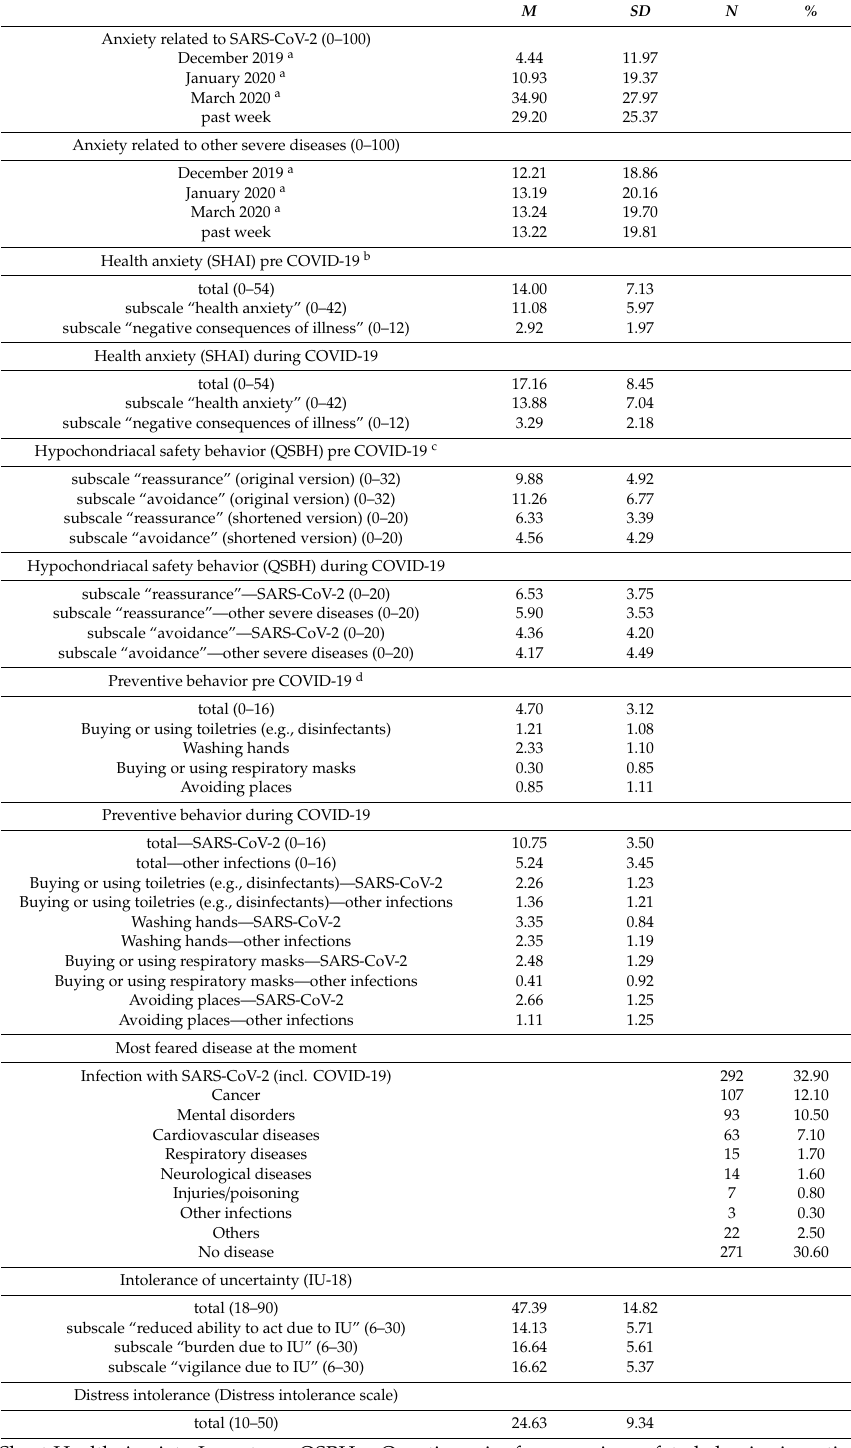
Table 1. Descriptive statistics of applied questionnaires and